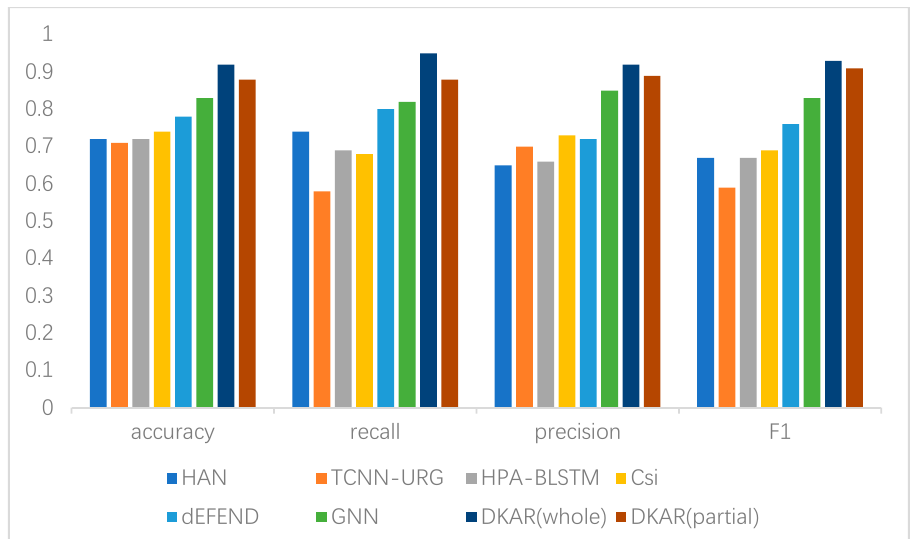
Figure 5. Performance comparison on the dataset of PolitiFact.